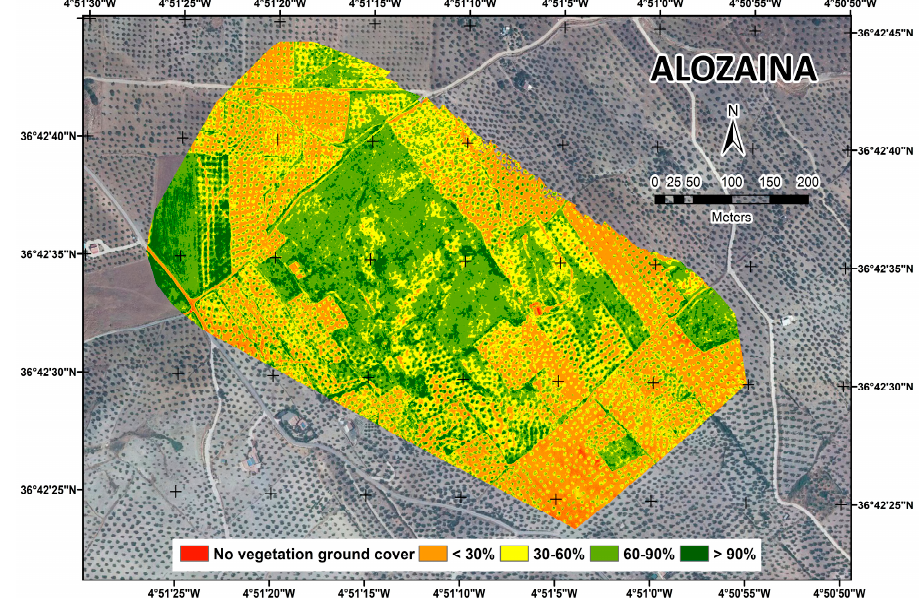
Figure 7. Quantification map of the VGC in Alozaina, made at a cover interval range of 30 % using IRVI index.